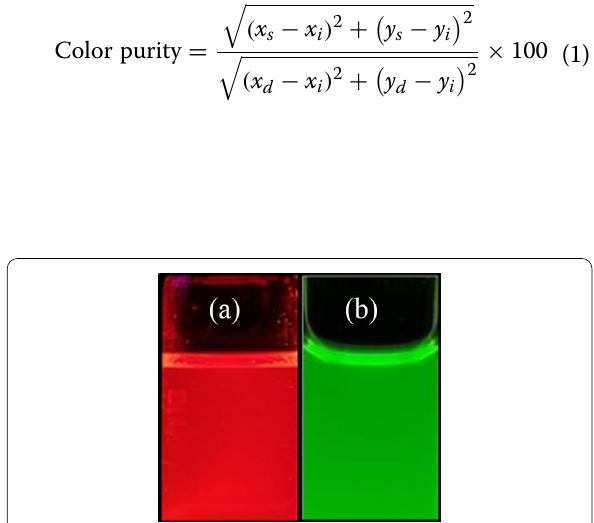
Fig. 1 Samples of a red and b green QDs